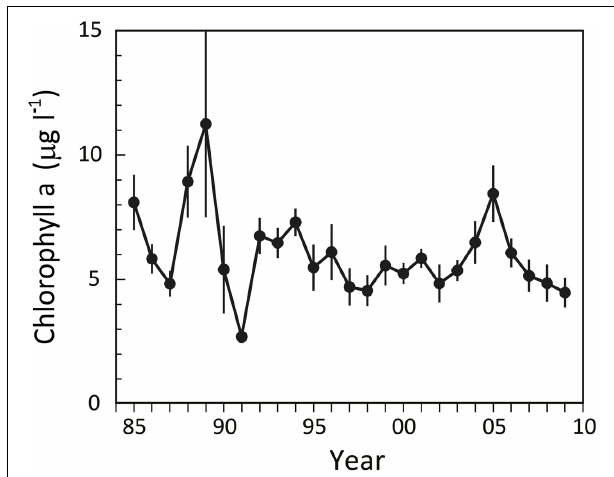
FIGURE 3 | Summer Chlorophyll a levels in the water column of the inner part of Odense Fjord from 1985 to 2009. Samples were taken in June–August at station OF122. Error bars indicate ± SE [ n = 3 (1985–1992); 7 (1993–1997); 12 (1998–2001); 26 (2002–2006); 10 (2007–2009)] (data kindly provided by The Danish Nature Agency).